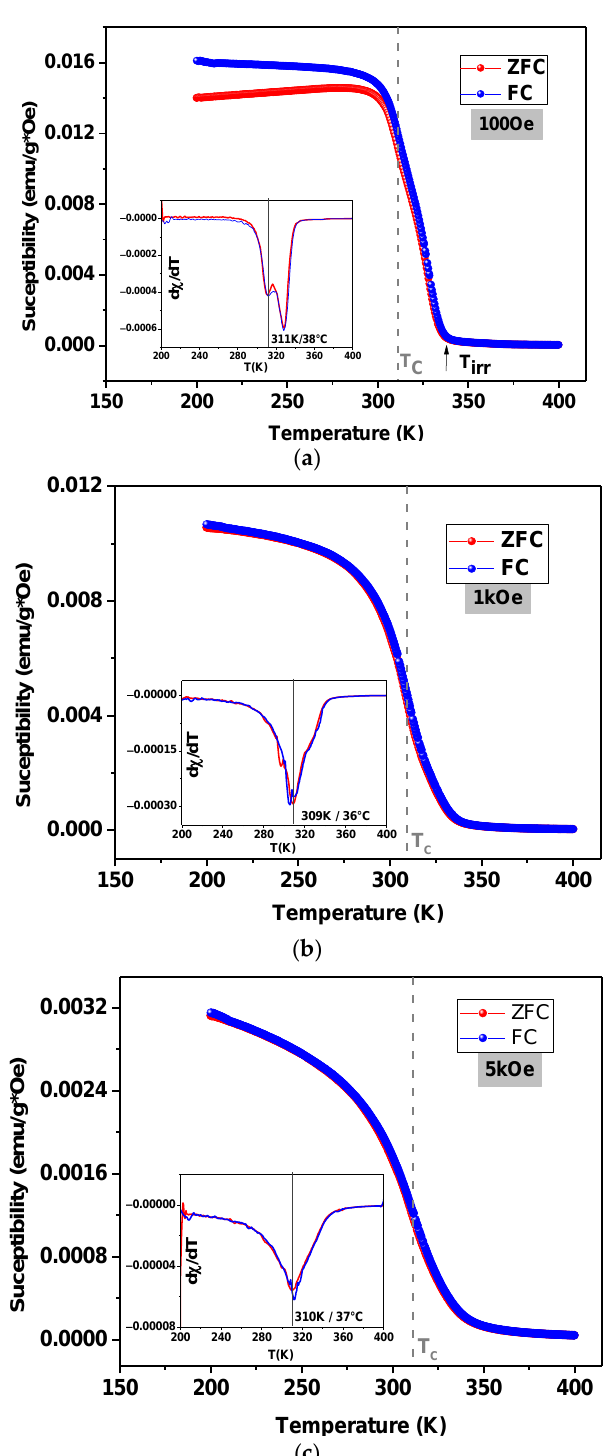
phase LSM are, respectively, 15.5 × 10 − 6 ◦ C − 1 and 11.4 × 10 − 6 ◦ C − 1 [41–43]. Hence, the LSM particles may be under residual stresses.